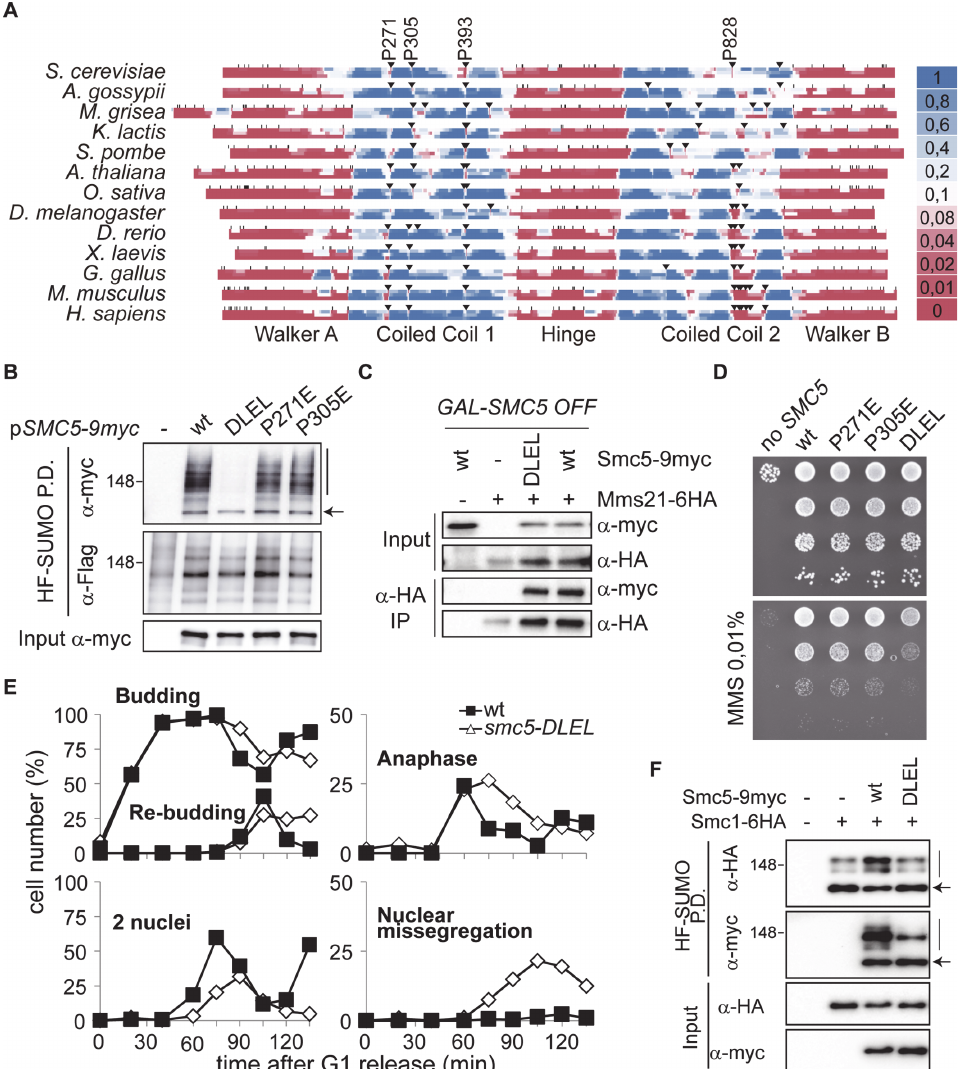
Fig 7. The coiled coil domain of Smc5 participates in activation of the Mms21 SUMO ligase. A . Coiled coil probability of the Smc5 protein sequence in different species ( Saccharomyces cerevisiae , Ashbya gossypii , Magnaporthe grisea , Kluyveromyces lactis , Schizosaccharomyces pombe , Arabidopsis thaliana , Oryza sativa , Drosophila melanogaster , Danio rerio , Xenopus laevis , Gallus gallus , Mus musculus , and Homo sapiens) ; sequences are aligned according to P393 position in budding yeast. Numerical values for coiled coil probability are colored as shown in the legend; small vertical lines mark position of proline residues, inverted arrowheads mark position of proline residues in coiled coils. B . HF-SUMO pull-down analysis from wild-type cells expressing the indicated SMC5-9myc alleles from a centromeric plasmid; DLEL mutant contains the H391D, P393E, and E394L mutations. C . Co-immunoprecipitation analysis of the Smc5-Mms21 interaction in wild-type and smc5-DLEL mutant cells. GALp-SMC5 cells expressing wild-type SMC5 or smc5-DLEL allele from a centromeric vector were shifted to glucose for 6 h before collection. Mms21-6HA was immunoprecipitated from protein extracts (input) with anti-HA beads (IP); samples were analyzed by SDS-PAGE and immunoblotting with the indicated antibodies. D . Growth test analysis of GALp-SMC5 cells transformed with the indicated plasmids and plated in glucose-containing media at 30°C in the presence or absence of MMS 0.01%. E . Nuclear segregation defects in smc5- DLEL cells after DNA damage. Wild-type and smc5-DLEL cells were arrested in G1 with alpha factor, treated with MMS 0.01% for 30 min, and released into the cell cycle; samples were taken at the indicated times for microscopic analysis, as in Fig. 1E. F . HF-SUMO pull-down analysis in GALp-SMC5 SMC1-6HA cells expressing the indicated SMC5-9myc alleles from a centromeric vector; cells were shifted from galactose to glucose 6 h before collection to switch off the GAL promoter. In B and F, arrow points to unmodified SMC proteins; vertical bars are sumoylated forms.